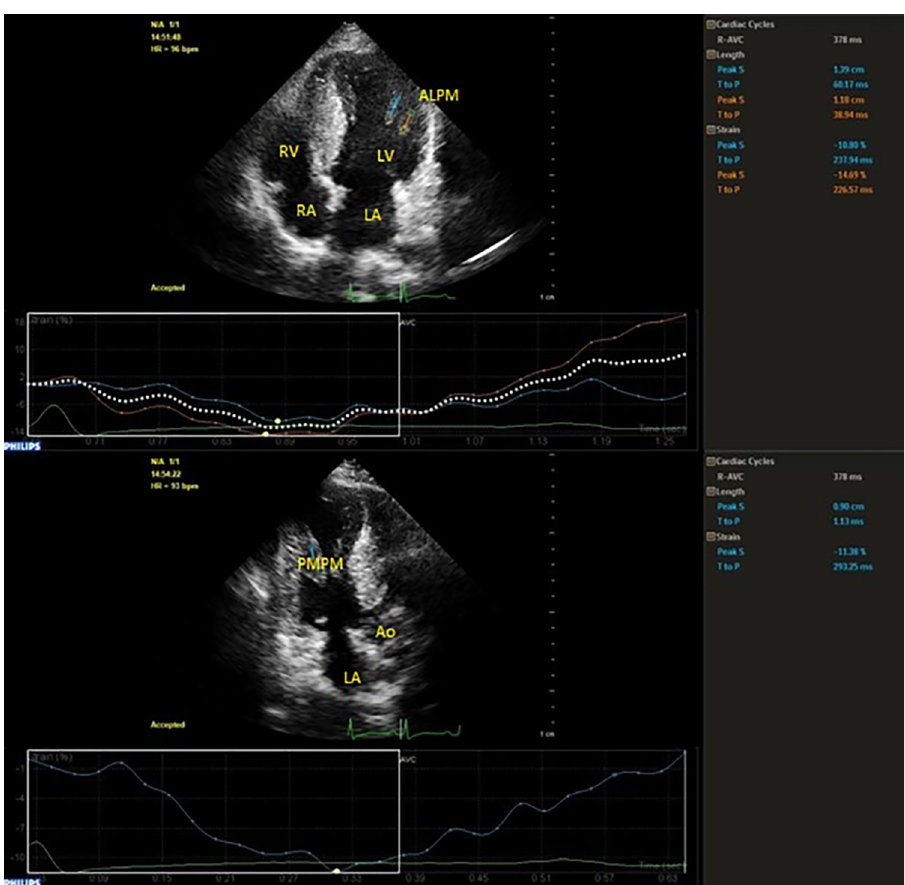
Fig 1. Measurement of ALPM and PMPM free